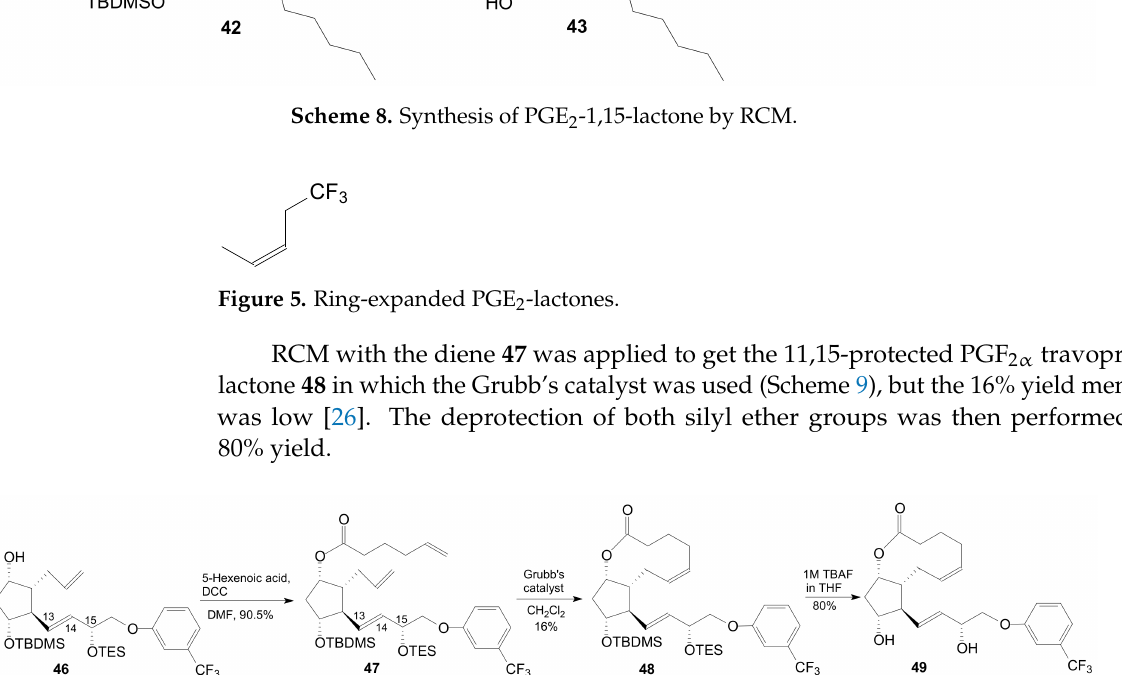
Table 2. ∆ 12 -PGJ 2 -, PGJ 3 -1,15-lactones and their analogs: method of synthesis and yield. Compound